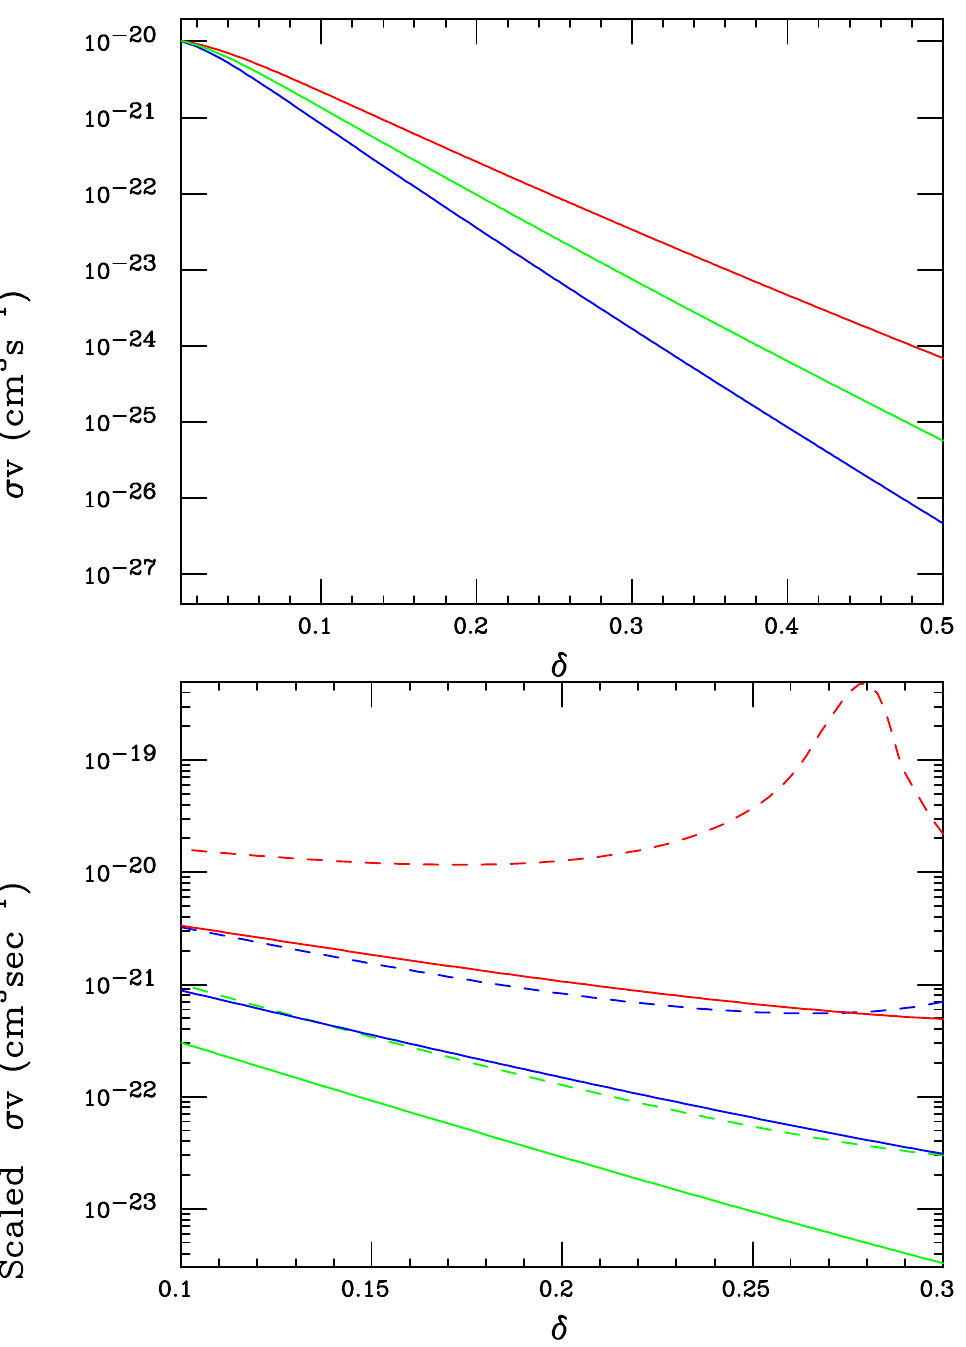
Figure 11 . Top: explicit dependence of the annihilation cross section on the parameter (cid:14) with all others held (cid:12)xed demonstrating the e(cid:11)ects of Boltzmann suppression. From top to bottom the curves are for x F = 20(25 ; 30), respectively. Bottom: examples of thermally weighted annihilations cross sections as functions of (cid:14) assuming (cid:14) A = 0 : 5; the red(blue, green) curves correspond to x F = 20(25 ; 30) while the solid(dashed) correspond to h = 0 : 3(0 : 4), respectively.